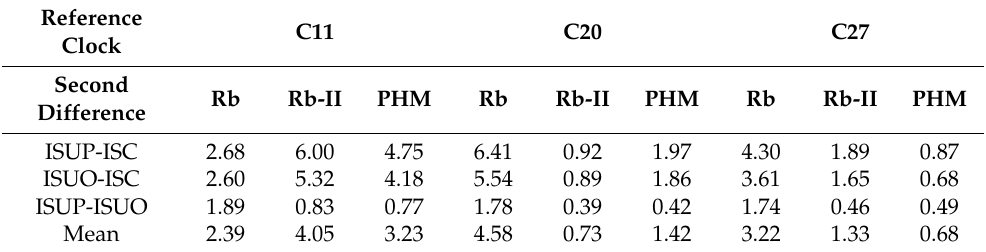
Table 2. The accuracy statistics of different reference clocks (ns).